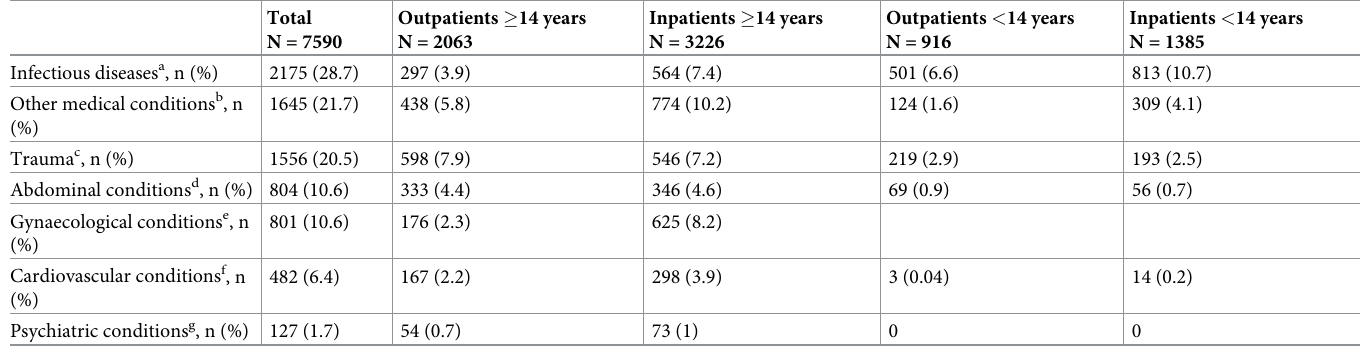
Table 1. Diagnoses of 7590 patients seen at the emergency room of the Saint Francis referral hospital in Ifakara, Tanzania from July 1 st , 2020, to June 30 th 2021.